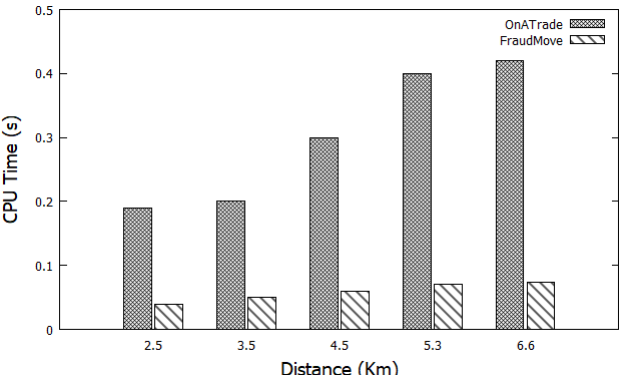
Figure 13. Comparing FraudMove to OnATrade (performance).